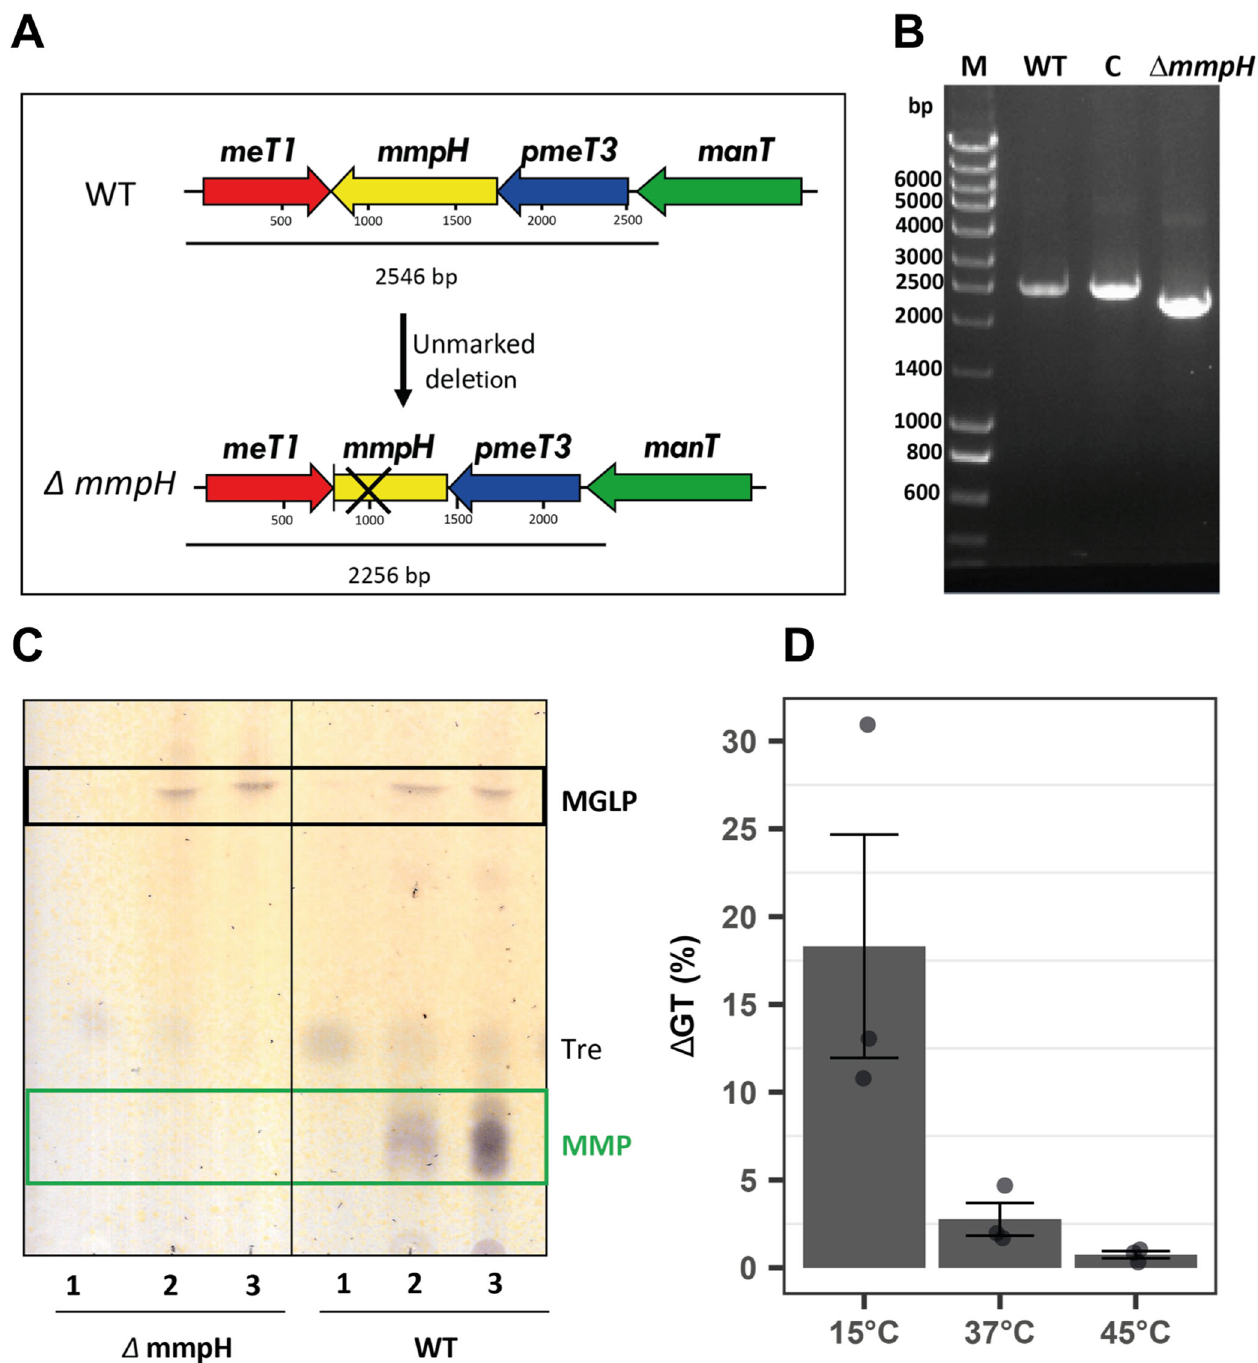
Fig. 6 Effects of the inactivation of mmpH on the growth of M. smegmatis . A Genetic organization of mmpH and neighboring genes in M. smegmatis and in the unmarked mmpH- negative mutant. The deletion site on mmpH is marked by a cross. B PCR con fi rmation of M. smegmatis p2NIL - Δ mmpH -sel transformants. M, molecular weight marker; WT, ampli fi cation from M. smegmatis DNA; C, Msmeg:p2NIL- Δ mmpH -sel negative transformant; Δ mmpH , successful transformant with evident loss of a 290 bp fragment from the mmpH gene. C TLC analysis of PMPS puri fi ed from WT and Δ mmpH M. smegmatis . Tre, trehalose. Lanes 1, 2, 3 elution with 40, 60 and 80% (v/v) methanol. D Relative difference between the generation time (GT) of WT M. smegmatis and the Δ mmpH mutant (Fig. S11B) grown at the indicated temperatures in GBM. Error bars represent SEM of three